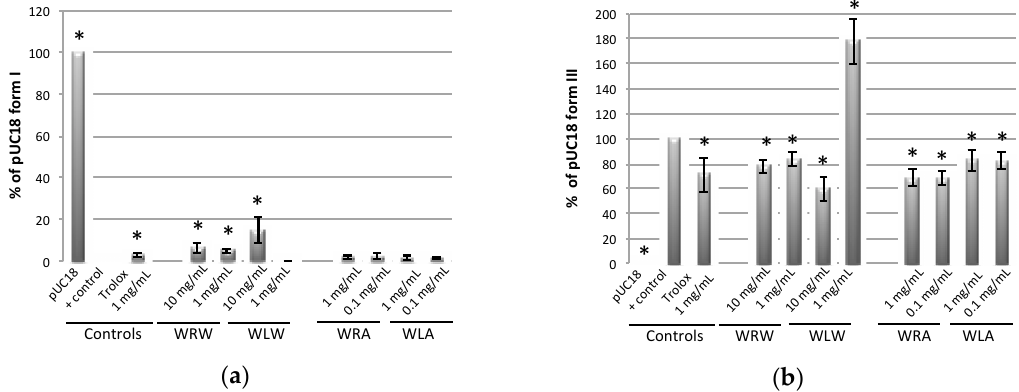
Figure 1. Antioxidant activity of Euterpe oleracea extracts in the DNA nicking assay indicating: ( a ) protection of supercoiled form I; and ( b ) formation of nicked linear form III; W: Wassaye ( E . oleracea ); R: roots; L: leaflets; W: water; A: acetone/water 70/30; (* p < 0.05; n = 3).